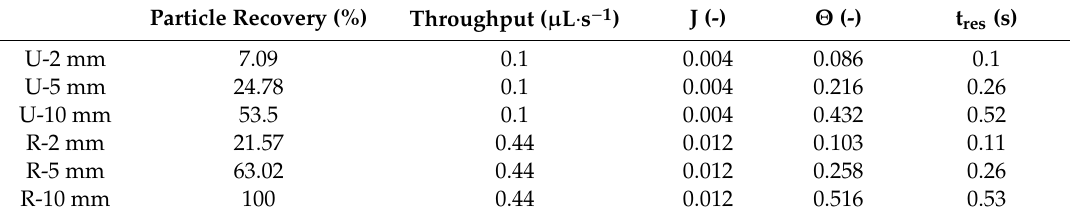
Table 2. Comparative analysis of all channel configurations for the same inlet fluid velocity (1.92 cm · s − 1